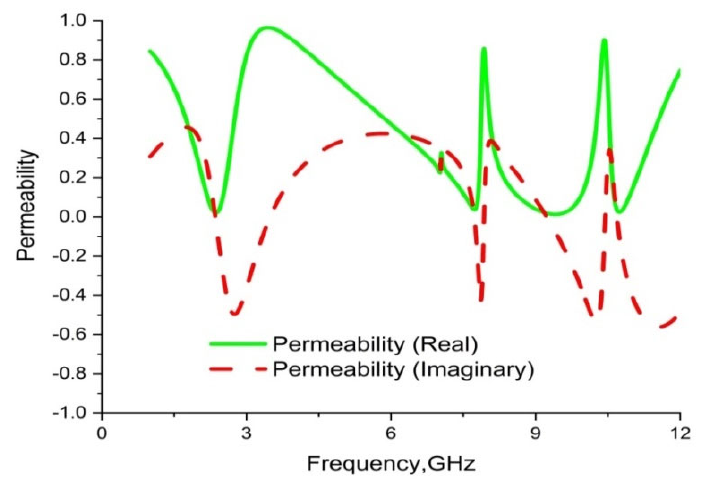
Figure 15. Graph of real and imaginary magnitudes of permeability ( μ ) for the unit cell.